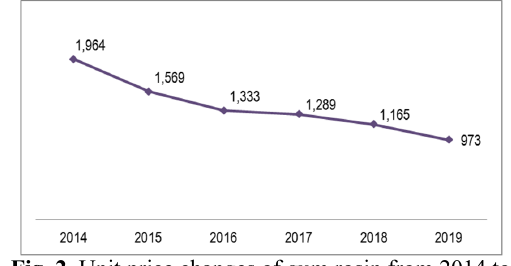
Fig. 1. Changes in total volume (ton) and value (million Fig. 2. Unit price changes of gum rosin from 2014